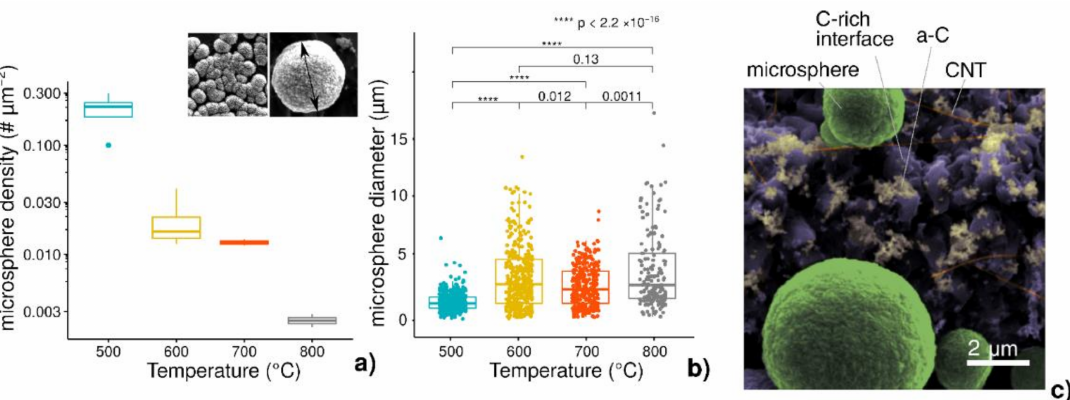
Figure 7. Carbon microsphere ( a ) density, ( b ) average diameter for the different temperatures, ( c ) colored SEM